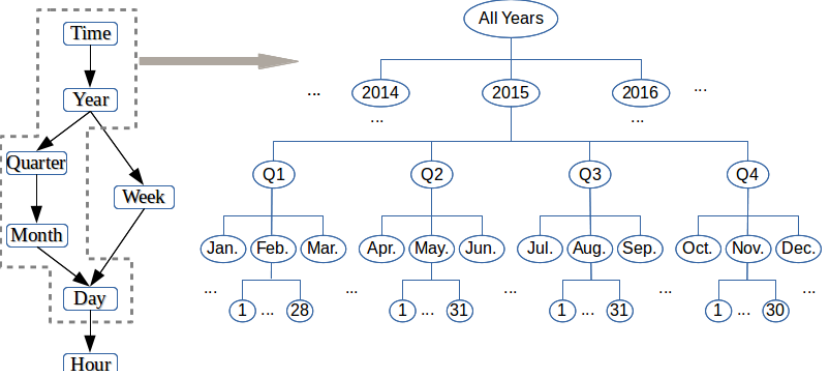
Figure 1. Hierarchical structure of the time dimension. The dashed polygon part is handled in this paper. An instance of this structure is on the right side.